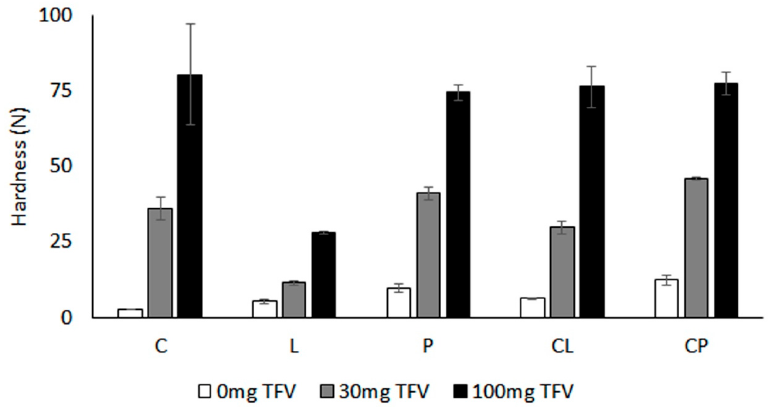
Figure 2. Hardness (N) obtained for the tablets.